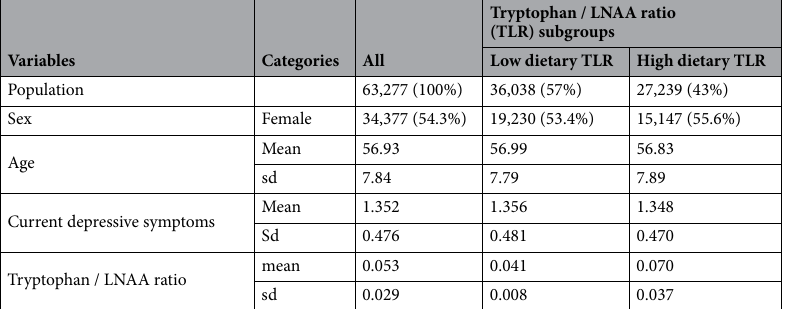
Table 1. Descriptive statistics for low and high dietary TLR subgroups and the total population. LNAA large neutral amino acids, TLR tryptophan to other LNAA ratio, sd standard